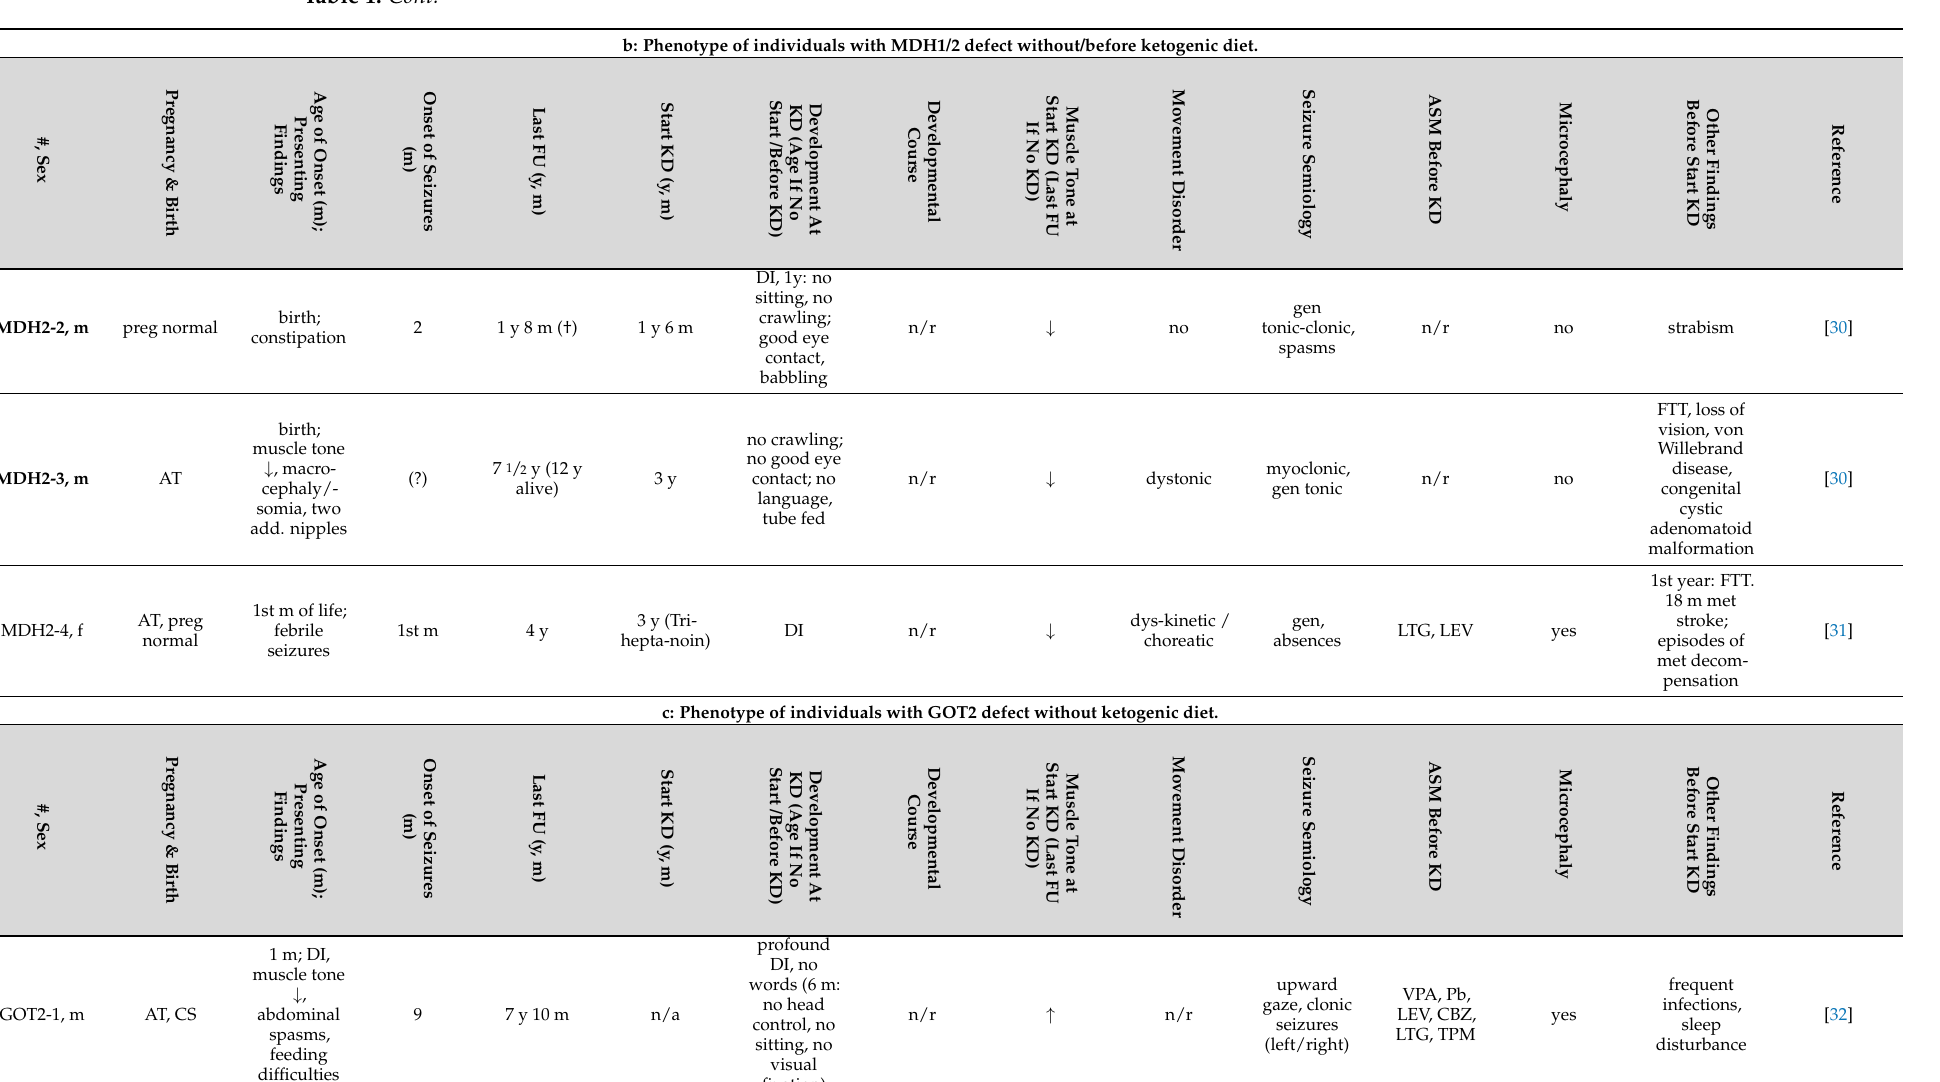
Table 1. Cont. b: Phenotype of individuals with MDH1/2 defect without/before ketogenic